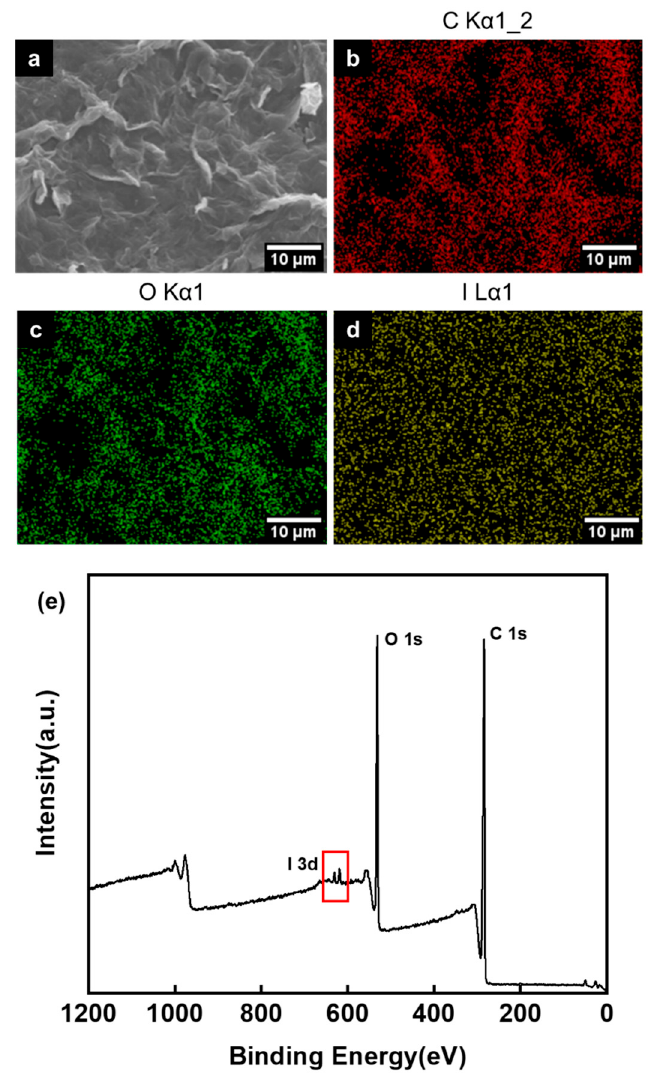
Figure 5. ( a ) SEM image, ( b – d ) elemental mapping images and ( e ) XPS wide scan spectrum of GO-120 after iodine adsorption.